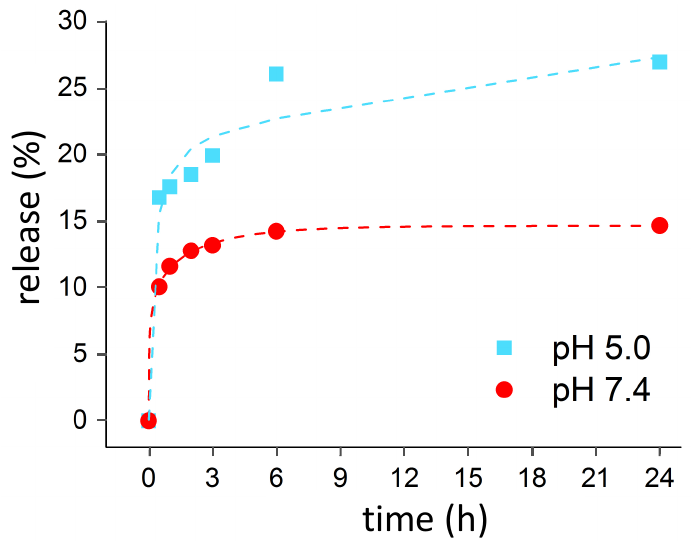
Figure 3. Cumulative release tests of TO-APTES-CIN powder at different pH values. Lines are added only as a guide for the eye.